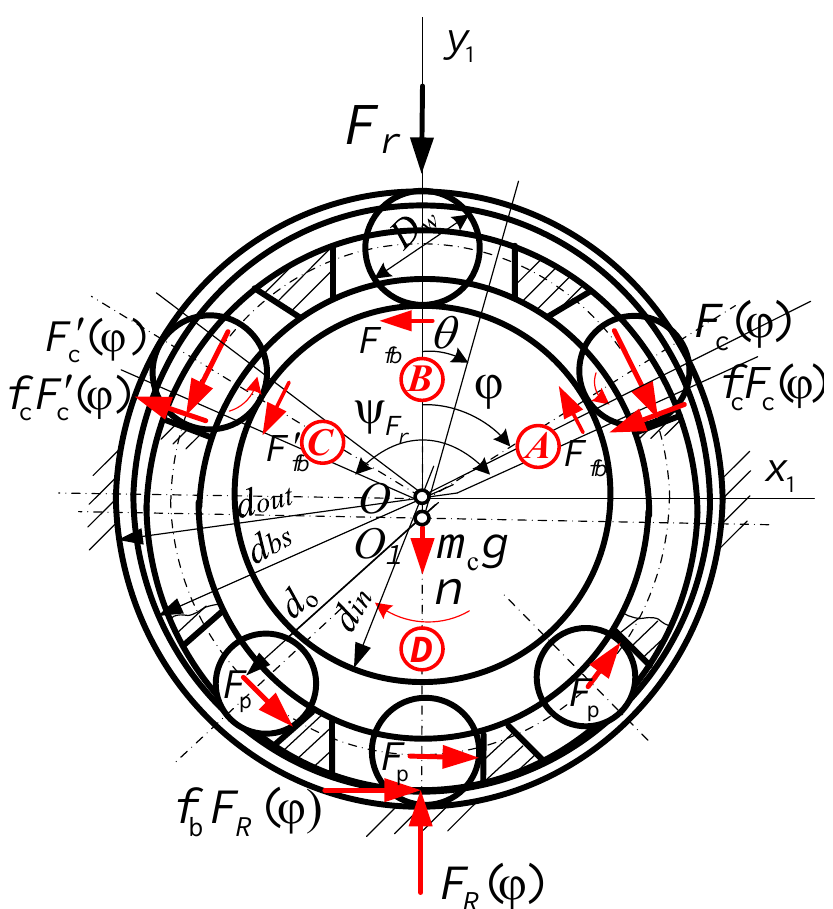
Figure 1. The scheme of the interaction of rolling elements with the cage.